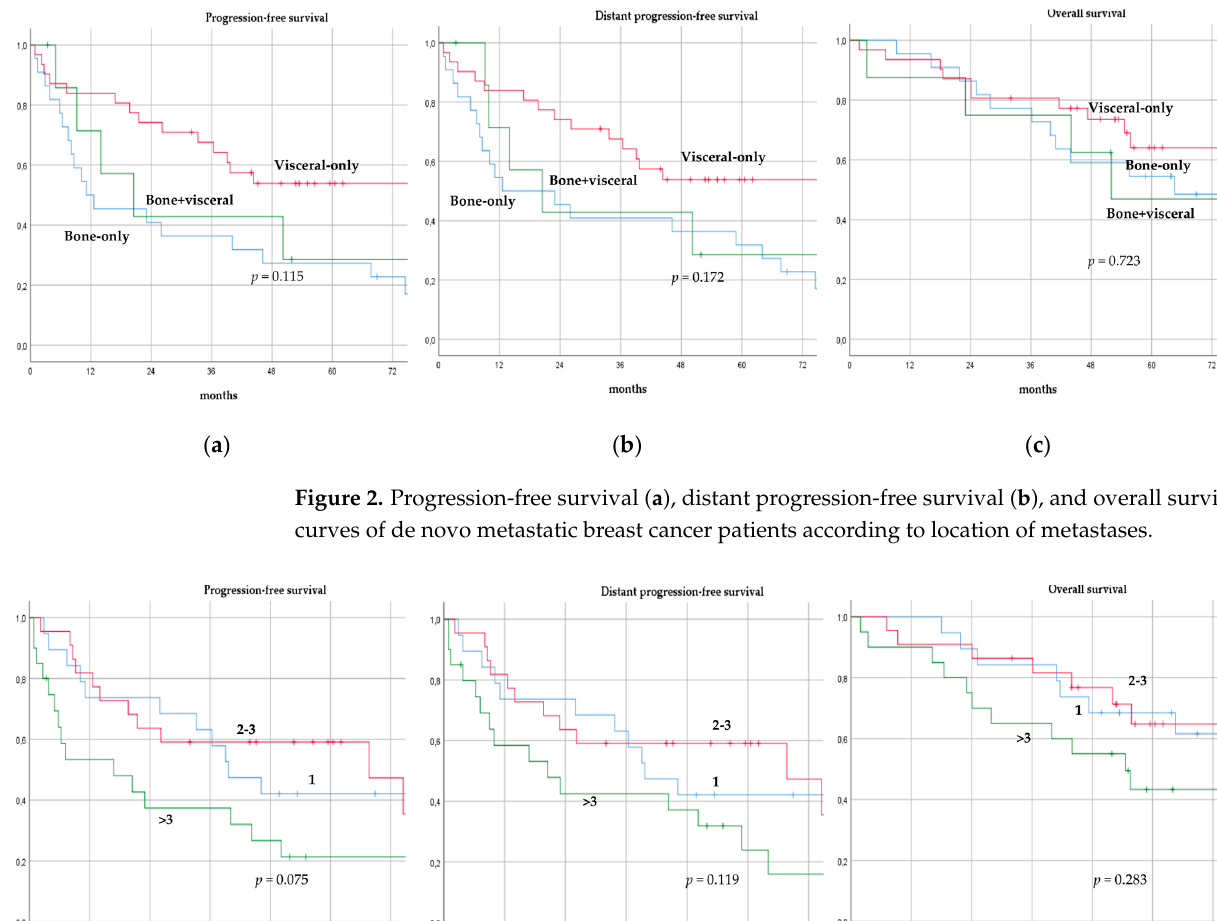
Figure 1. Progression-free survival ( a ), distant progression-free survival ( b ), and overall survival ( c ) curves of de novo metastatic breast cancer patients according to menopausal status.